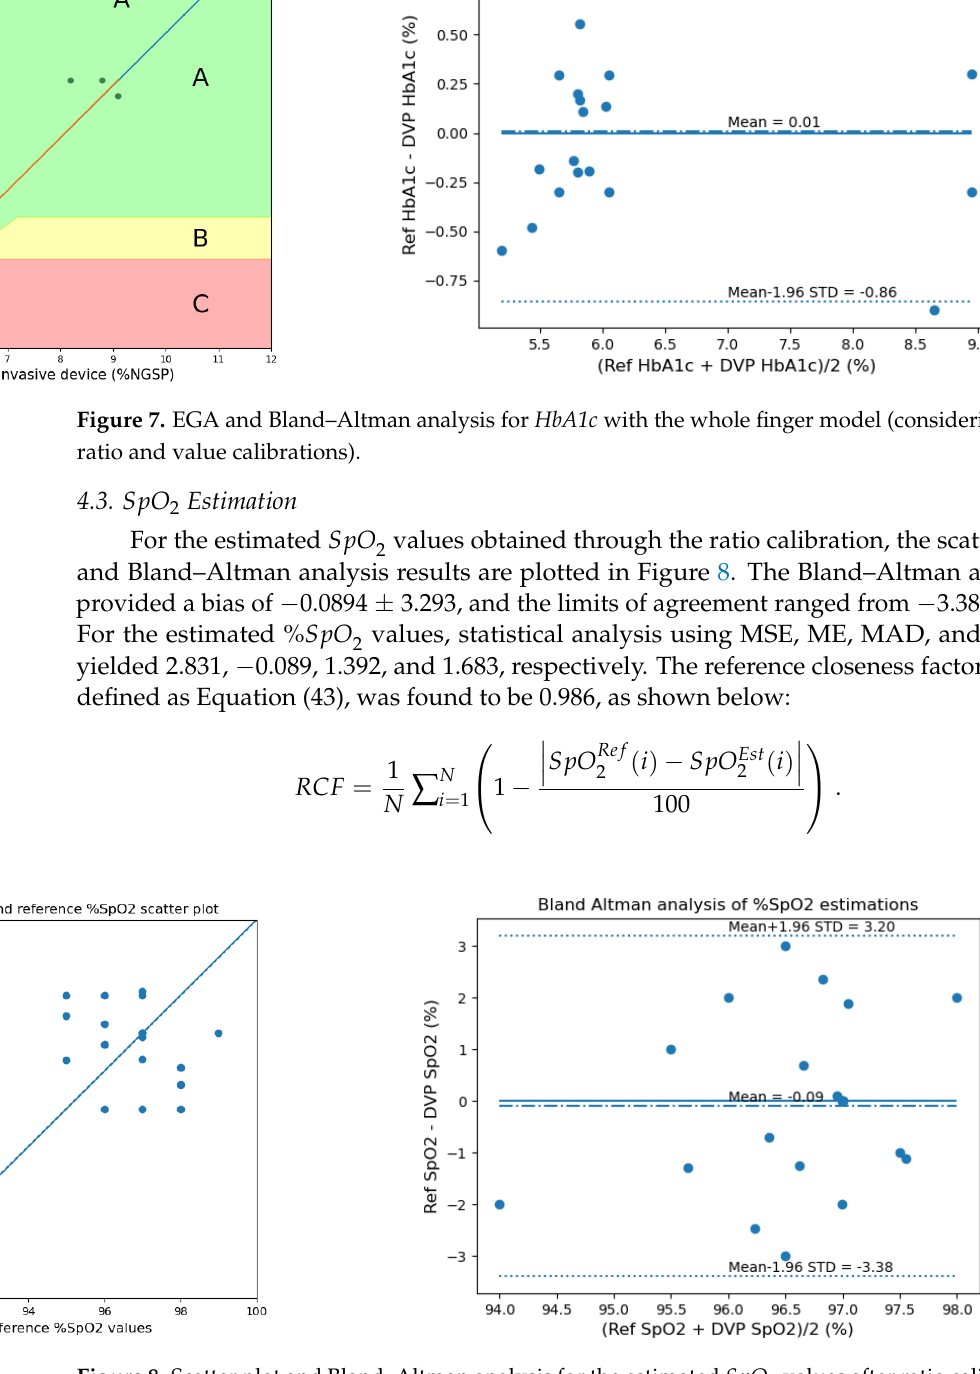
Table 4. HbA1c estimation performance comparison between this study and the previous study. Metric